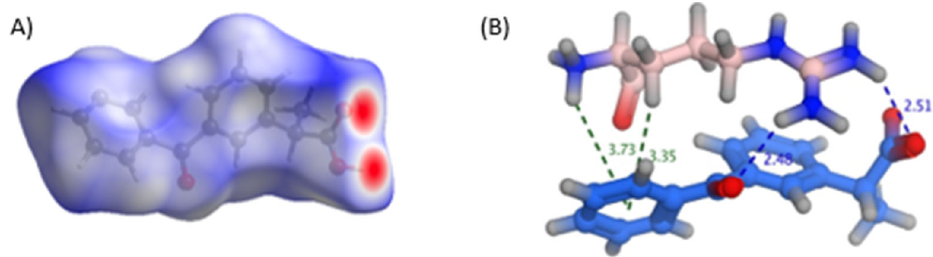
Figure 6. ( A ) Hirshfeld surface analysis of ketoprofen crystals and ( B ) possible interactions formed upon docking arginine onto the ketoprofen surface.